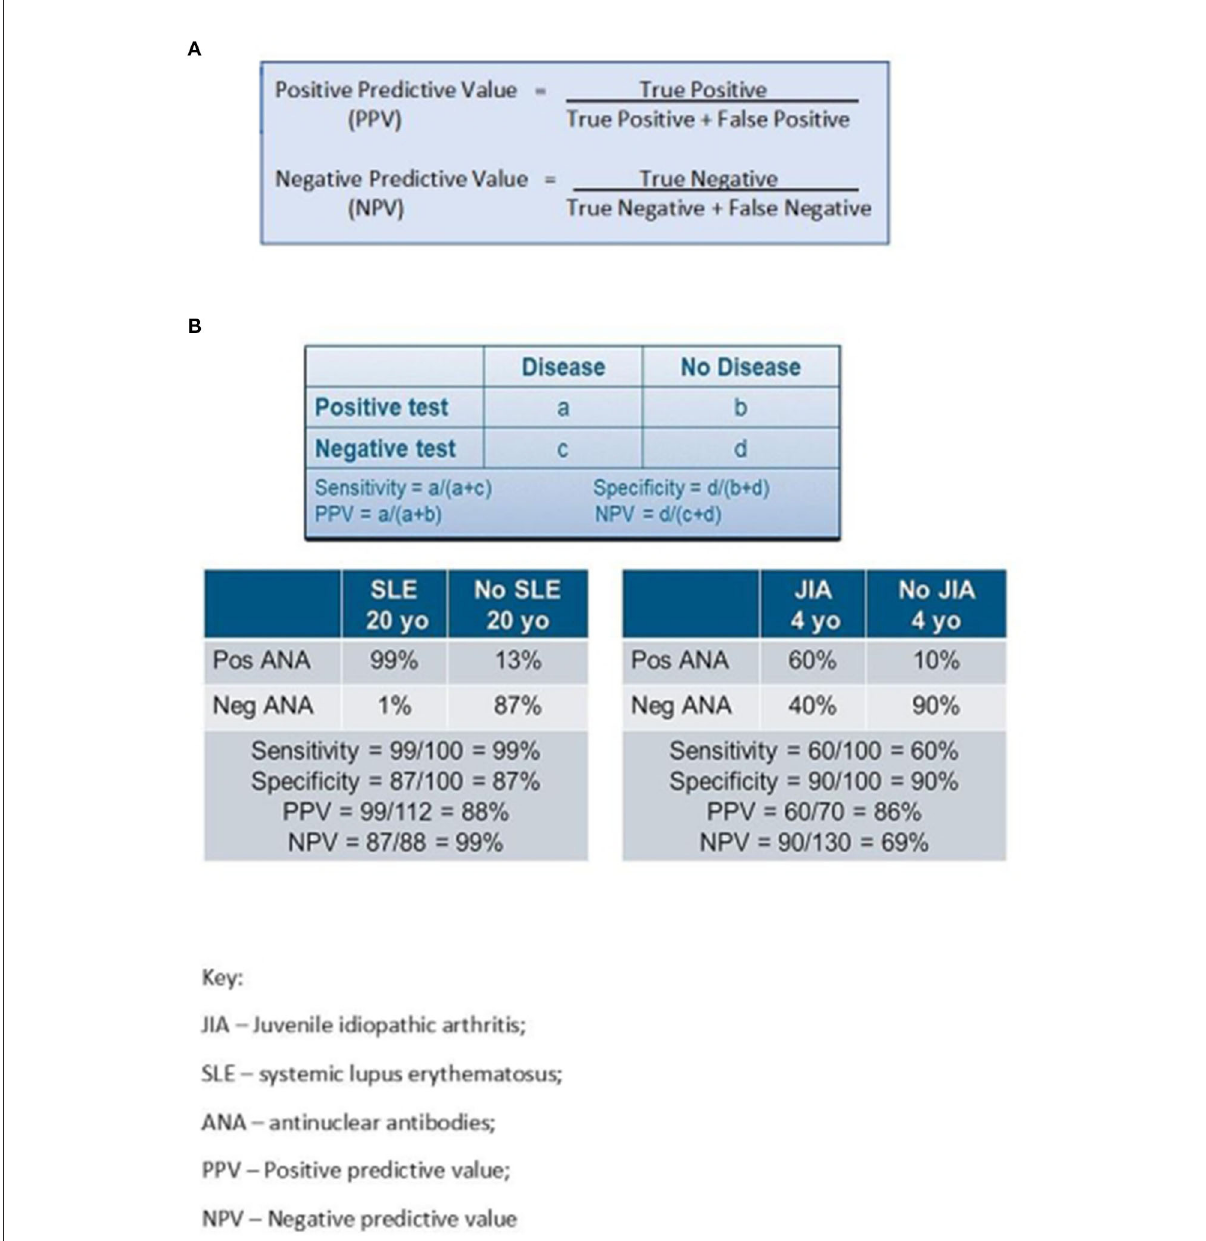
FIGURE1 (A, B) Sensitivity, specificity, positive predictive value and negative predictive value of ANA testing.